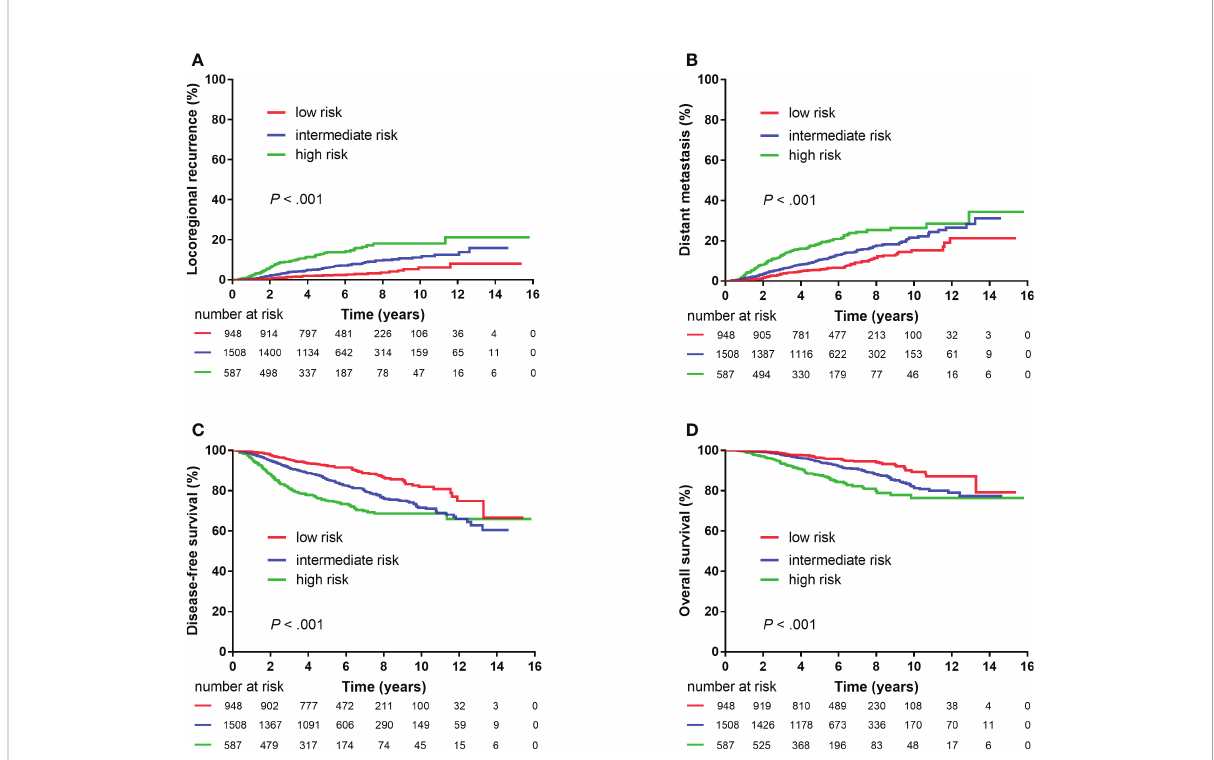
FIGURE 3 Kaplan – Meier plots showing locoregional recurrence (A) , distant metastasis (B) , disease-free survival (C) , and overall survival (D) among different risk groups (3,043